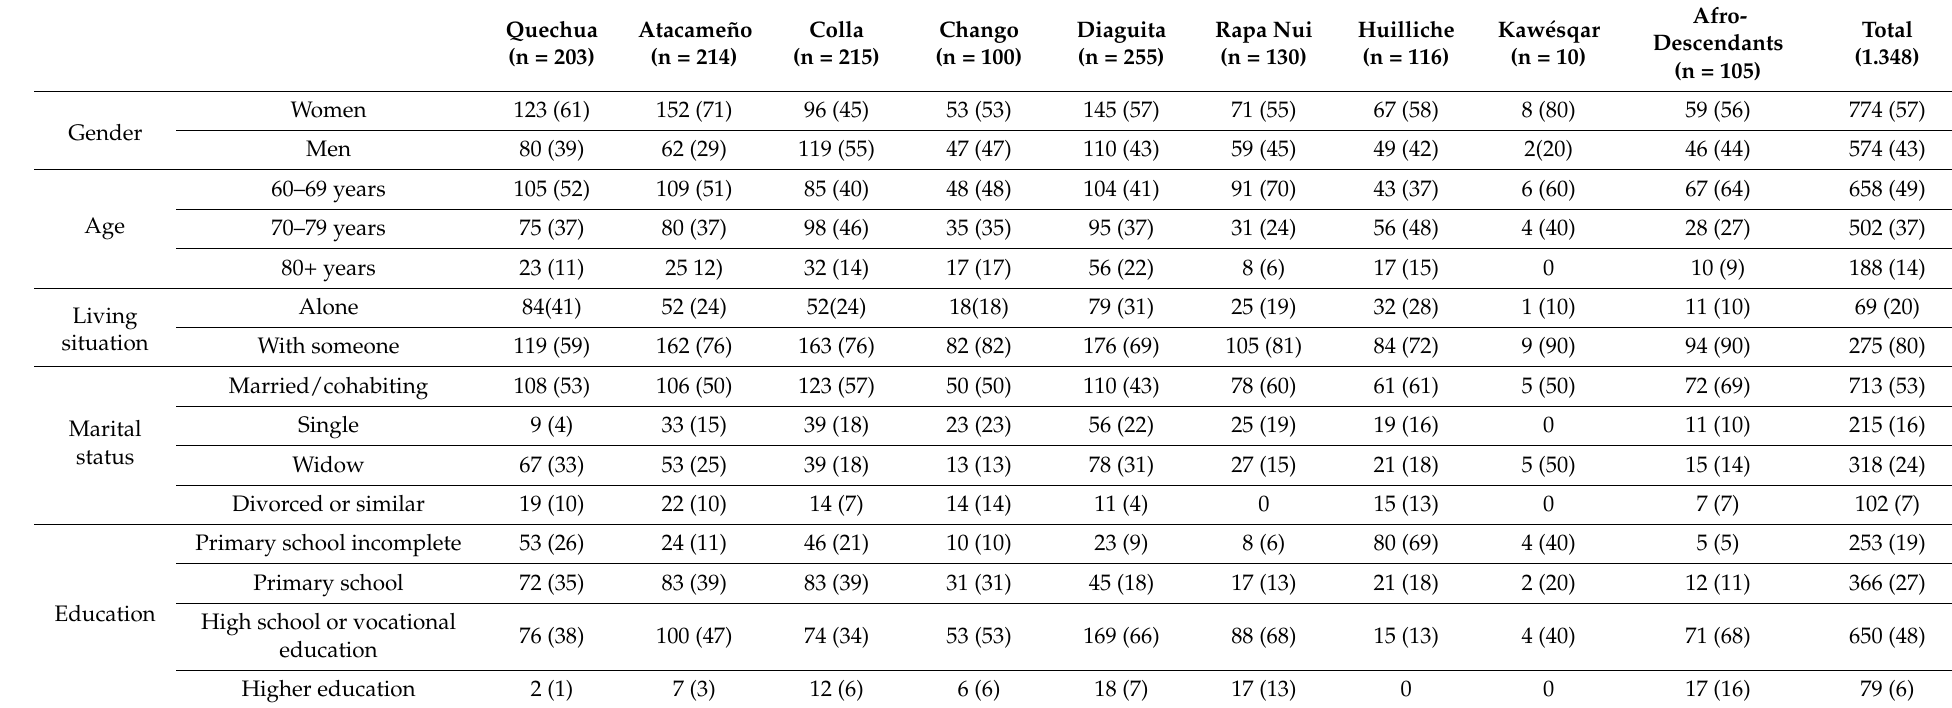
Table 1. Participant